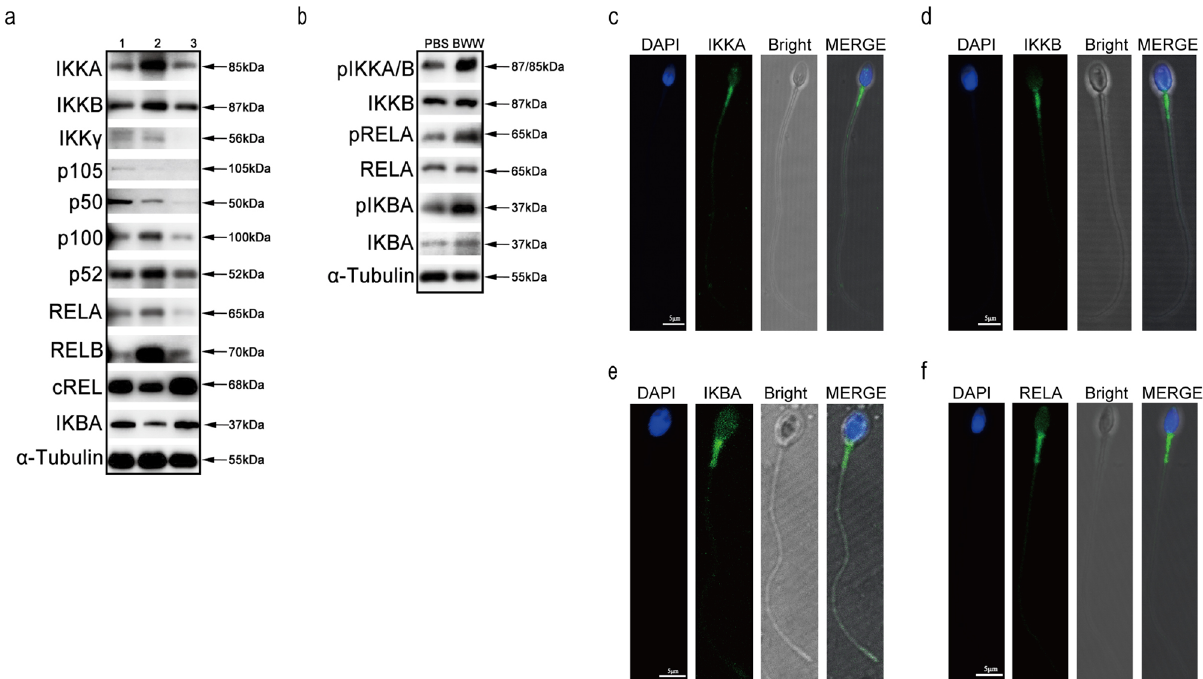
Fig. 1 Expression and localization of canonical NF- κ B proteins in human sperm. a Expression of IKKA, IKKB, IKK γ , p105/p50 (NF- κ B1), p100/p52 (NF- κ B2), RELA (p65), RELB, cREL, and IKBA in human sperm. α -Tubulin served as the loading control. Numbers represent samples of different individuals. b Phosphorylation states of IKKA/B, RELA and IKBA proteins in human sperm in PBS and BWW media. α -Tubulin served as the loading control. c – f Localization of IKKA ( c ), IKKB ( d ), IKBA ( e ) and RELA ( f ) proteins in human sperm. DAPI (blue) labeled the nuclei; IKKA, IKKB, IKBA, and RELA were stained with AlexaFluor488 (green) separately. Fluorescent images were merged with bright- fi eld images (Bright) shown in the MERGE panels. Scale bar: 5 μ m.